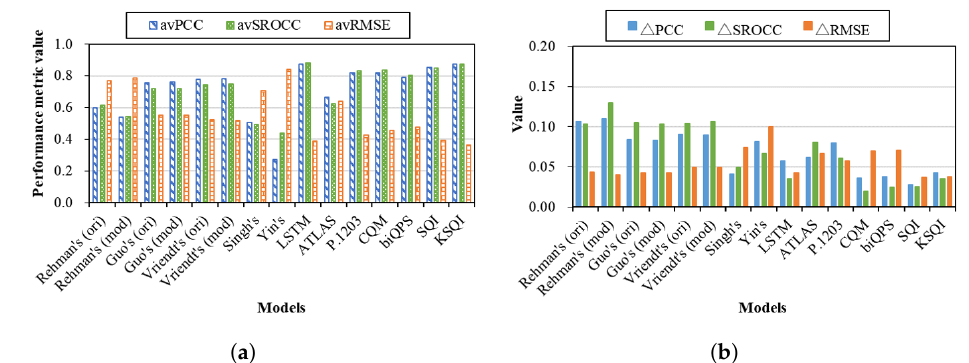
Figure 3. Average performance and mean difference of the models using the DBS1 , DBS2 , and DBS3 sets. ( a ) average performance; ( b ) mean